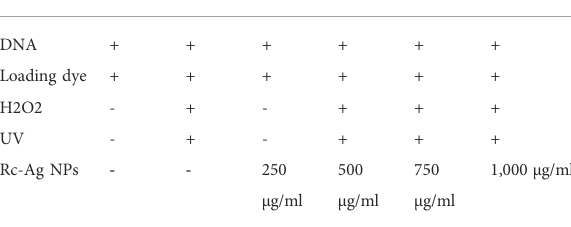
TABLE 2 Substances added to the wells for DNA damage activity